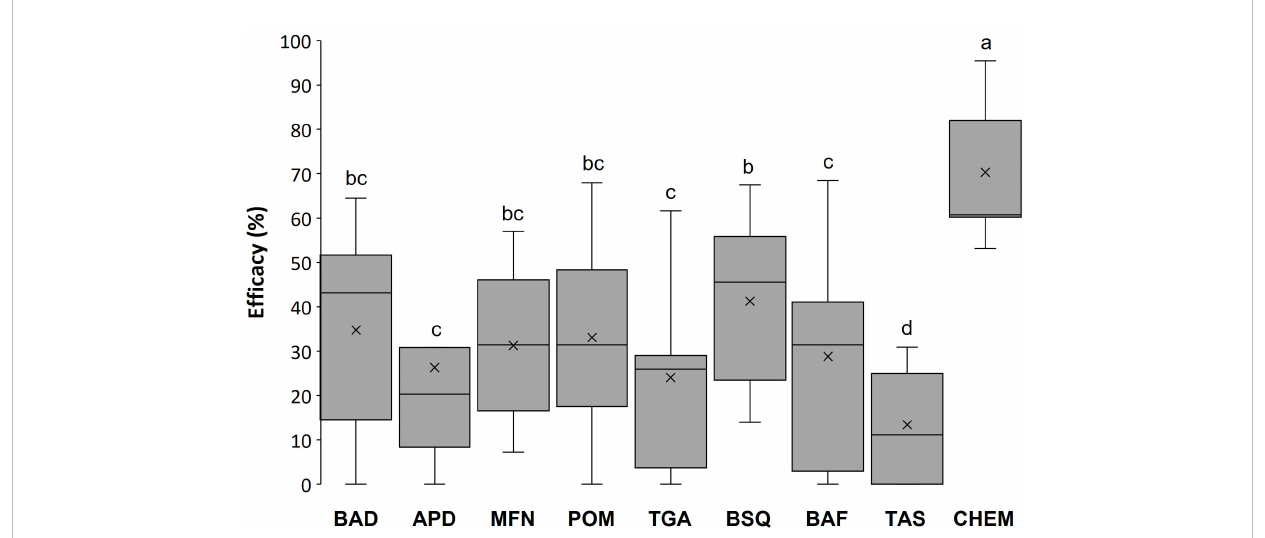
FIGURE 2 Ef fi cacy (%) of treatments with eight commercial biocontrol agents (BCAs) and a reference fungicide (CHEM) (see Table 1 for de fi nitions of the acronyms) in reducing gray mold in ripened grapevine berries. The box extends from the 25 th to 75 th quartile of the data distribution, the line crossing the box represents the median and the × indicates the average; whiskers extend to the maximum and minimum. Ef fi cacy was calculated during three seasons (2018 to 2020) in relation to an untreated control for berries treated in the vineyard sampled 1, 3, 6, 9, and 13 days after treatment (DAT), arti fi cially inoculated with a conidial suspension of Botrytis cinerea in the laboratory, and then incubated under optimal conditions for the pathogen for 1 week before disease severity assessment. Each box plot then represents 54 data points (3 years, 6 DAT, three replicates). Differences between treatments were signi fi cant at P < 0.001 and accounted for 16.5% of the total variance in disease severity. Different letters indicate signi fi cant differences according to the least-square difference test at P < 0.05.